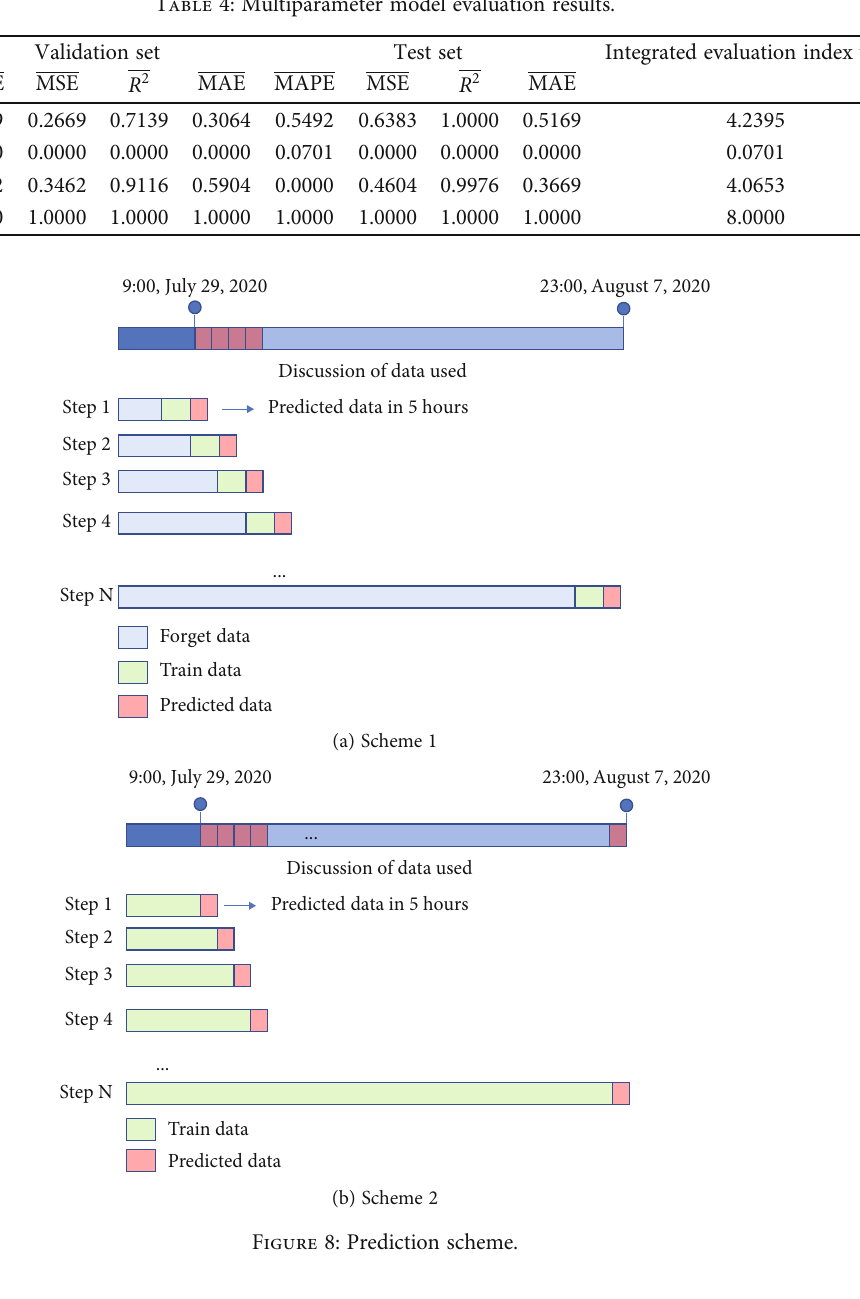
Table 4: Multiparameter model evaluation results.